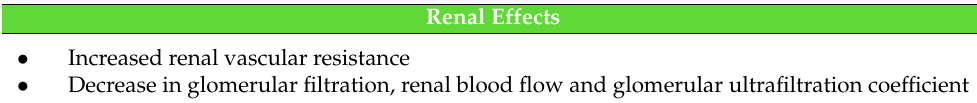
Table 4. Renal Effects.